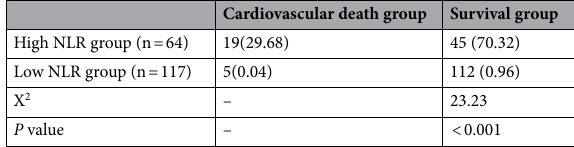
Table 4. Two-year follow-up results of patients in the high and low NLR groups. NLR, neutrophil to lymphocyte ratio.